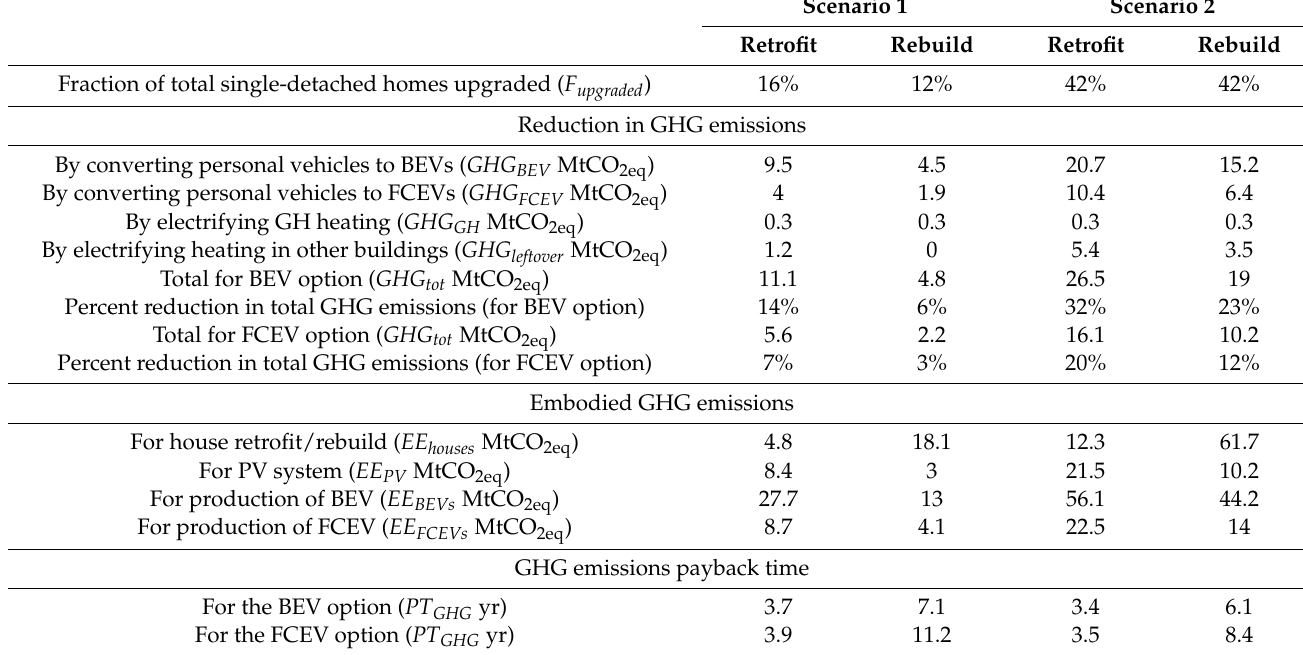
Table 9. GHG emission reductions, embodied emissions, and payback time associated with upgrading enough single- detached houses to achieve greenhouse (GH) crop production autonomy (scenario 1) and all houses that employ electric resistance heating (scenario 2). Scenario 1 Scenario 2 Retrofit Rebuild Retrofit Rebuild 16% 42% 42% Reduction in GHG